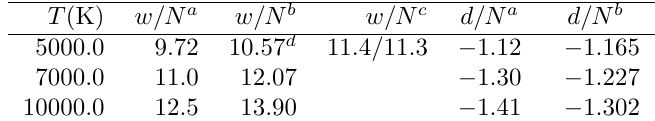
Table 5. widths w=N and shifts d=N (in units of 10 (cid:0) 9 rad s (cid:0) 1 cm 3 /atom) a Kr(cid:20)sljanin & Peach